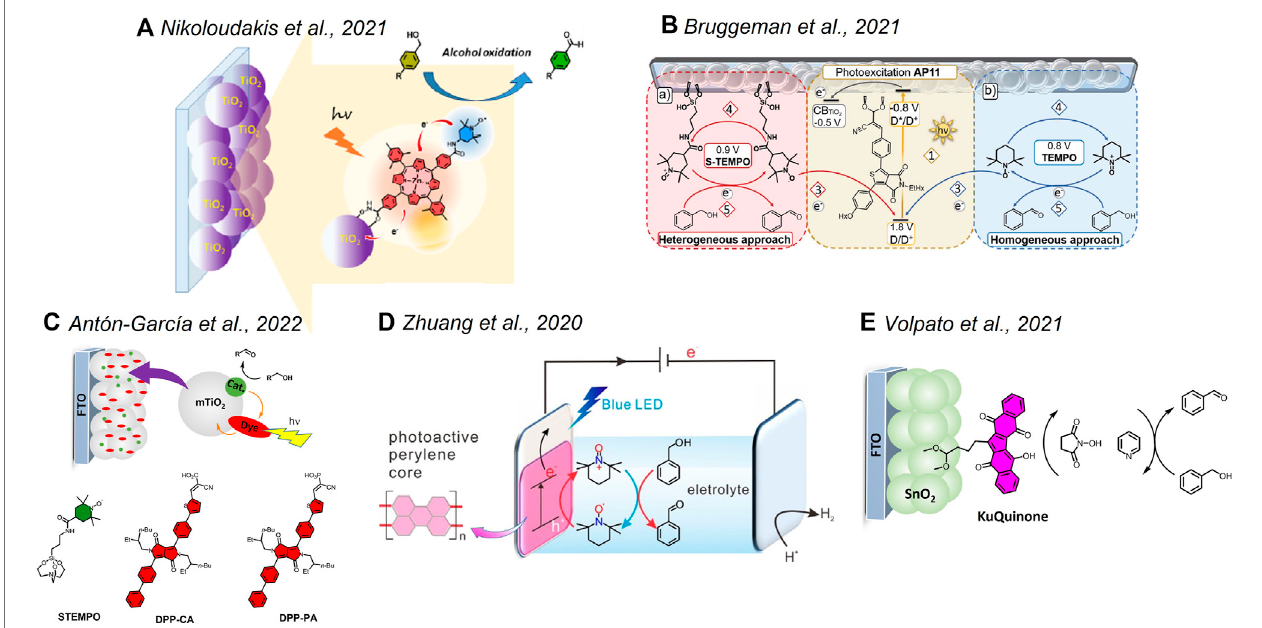
FIGURE 2 | Hybrid systems discussed in Section 3 based on noble-metal – free and organic components. (A) Adapted with permission from Nikoloudakis et al. (2021). Copyright 2021 American Chemical Society. (B) Reprinted with permission from Bruggeman et al. (2021b). Creative Commons Attribution-Noncommercial 3.0 Unported License. (D) Adapted with permission from Zhuang et al. (2020). Copyright 2020 American Chemical